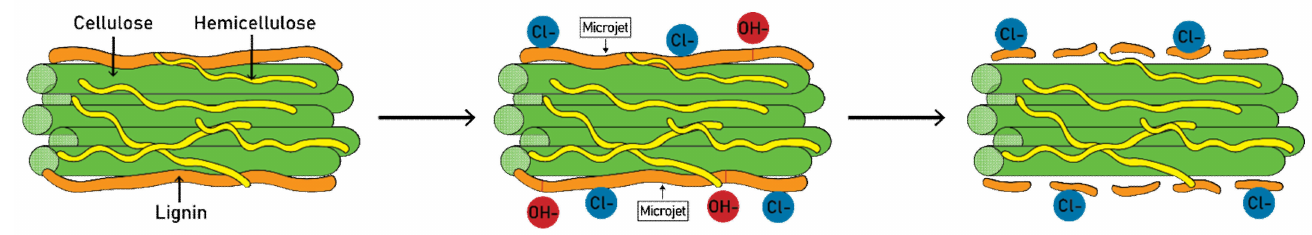
Figure 4. Process mechanism of ultrasound-assisted NaOH-aqueous DES pre-treatment. Adapted from Ong et al.